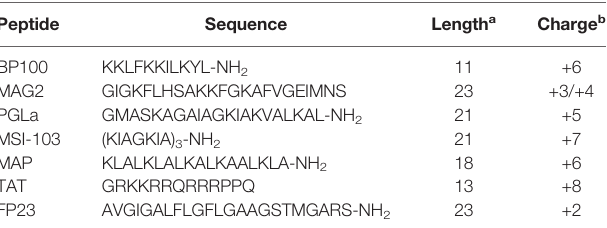
TABLE 1 | Sequences of used